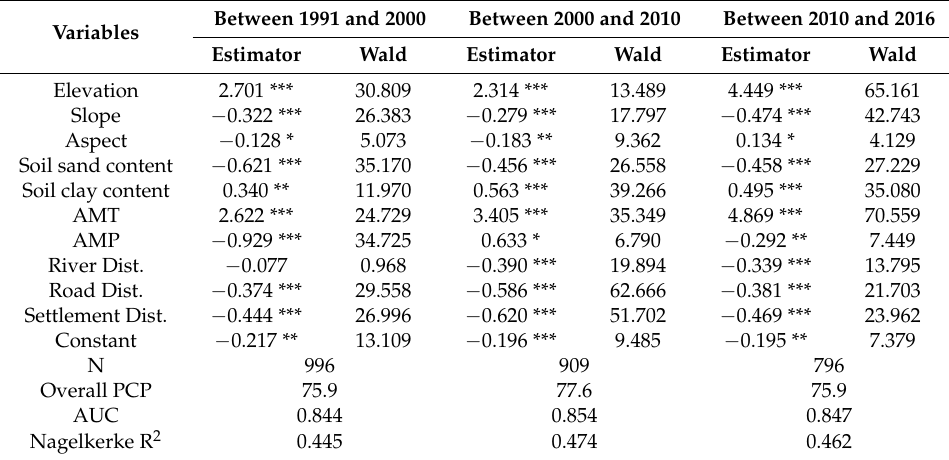
Table 8. Model estimates of farmland expansions driving forces within the DPR Korea region of study